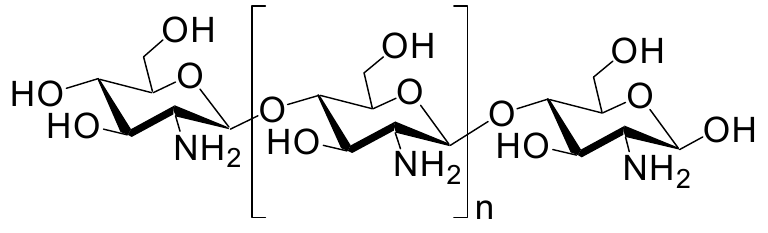
Figure 7. Structure of chitosan.